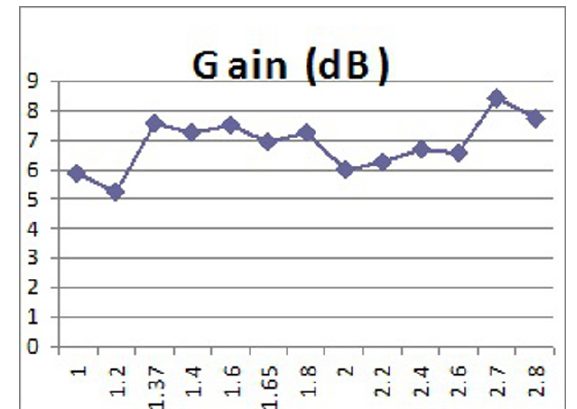
Figure 17. ChartshowingvariationinGain(dB)vs. Frequency(GHz) for 60° flare angle antenna.